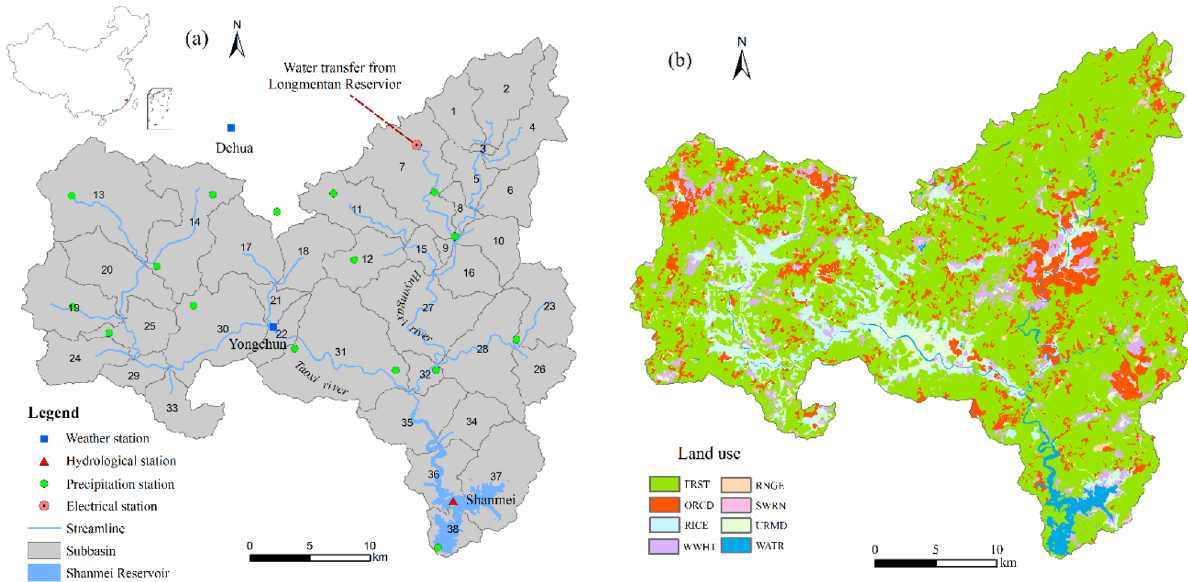
Figure 1. ( a ) Distributions of subbasins and river lines in the Shanmei Reservoir Basin (SRB); ( b ) distributions of the land use types in the SRB (Land use classes correspond SWAT codes to RICE (paddy field), WWHT (rainfed cropland), FRST (forest), ORCD (orchard), RNGE (grassland), URMD (medium density residential), WATR (water), and SWRN (bare